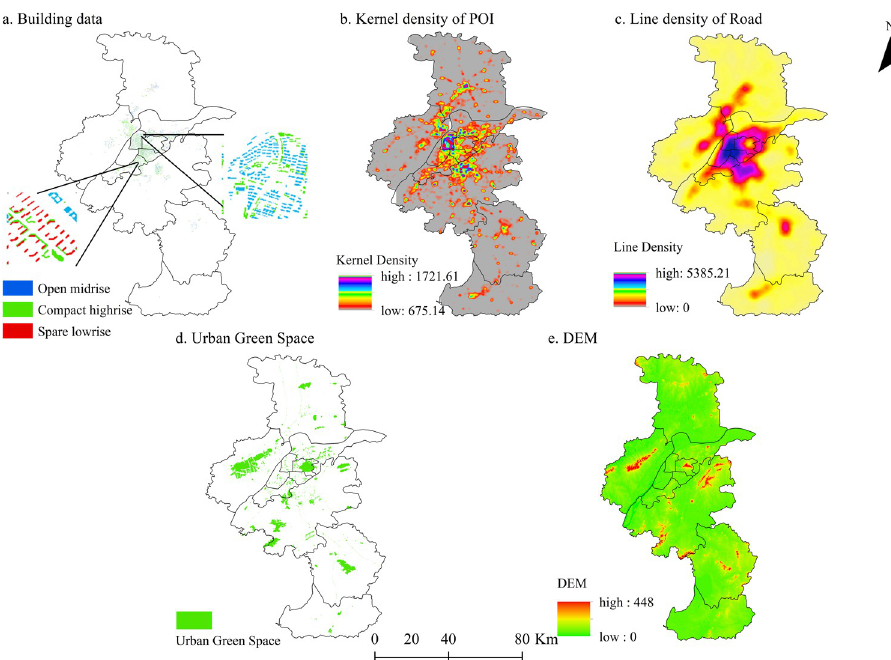
Fig 4. Spatial distribution of impact factors. Spatial distribution of impact factors. (a) Building date, open midrise (blue), Compare highrise (green), Spare lowrise (red),data source (http://ditu.amap.com); https://www.openstreetmap. org; (b) Kernel density of POI, data source (http://ditu.amap.com); (c) Line density of Road, data source (http://ditu. amap.com); (d) Urban Green Space(green), data source (http://www.resdc.cn/); (e) DEM, data source (http://www. gscloud.cn/). This map is drawn by the authors. This map was created using ArcGIS 1 software by Esri, © National Platform for Common Geospatial Information Services, © Resource and Environment Science and Data Center, © Baidu, © OpenStreetMap and contributors, Creative Commons Attribution 4.0(CC BY 4.0). https://doi.org/10.1371/journal.pone.0260205.g004 was higher than that in other districts, and the overall number of POI was the lowest in Gao- chun district. With an extremely low value, the regional nuclear density was the lowest in Yuhuatai District, whereas it was the highest in Qinhuai District. The spatial clustering distri- bution of POI in each region exhibited different trends. Qixia District and Luhe District corre- sponded to the distribution of "upper low high", with percentages of points between the lowest